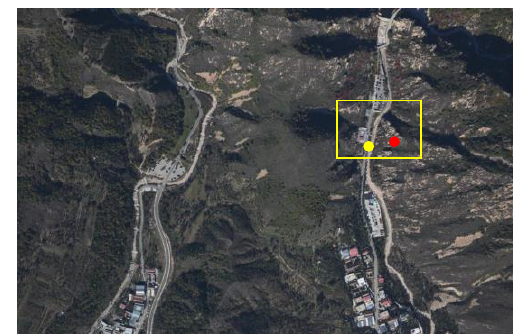
Figure 6. The perspective projection of a ground control point on an